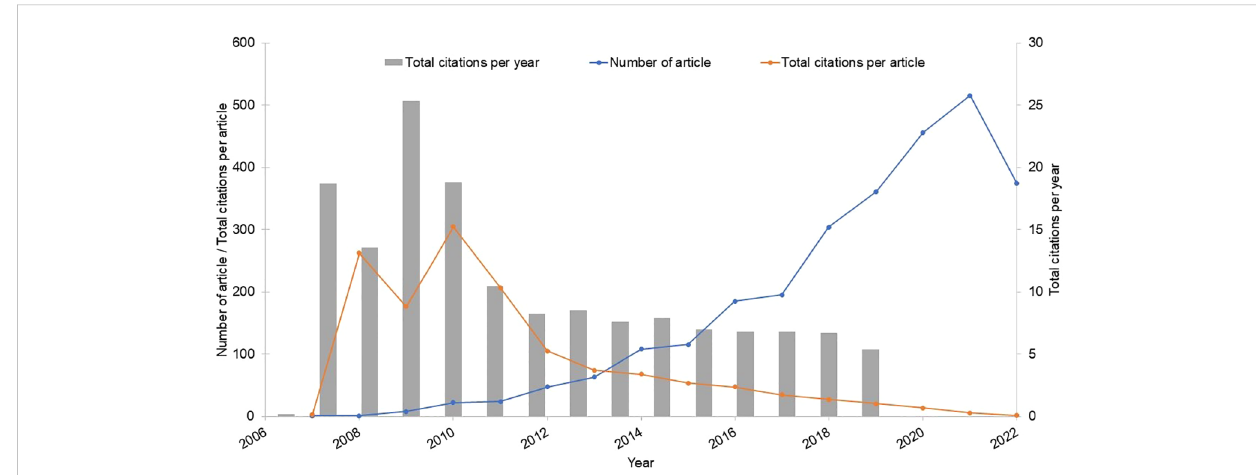
FIGURE 1 Worldwide publication and citation history on biochar-based smart fertilizers from 2007 to